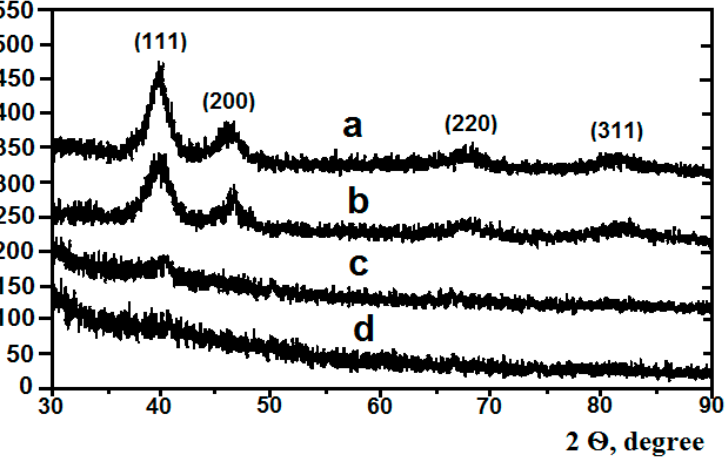
Figure 12. X-ray data for sample of hybrid metal–mesogenic nanosystem Ag / 4-cyano-4 (cid:48) -pentylbiphenyl (1:10 w / w%), encapsulated in poly-para-xylylene (PPX) film at 450 K ( a ), 300 K ( b ), 250 K ( c ), and 200 K ( d ) (Y-axis is the intensity of the signal in related units).